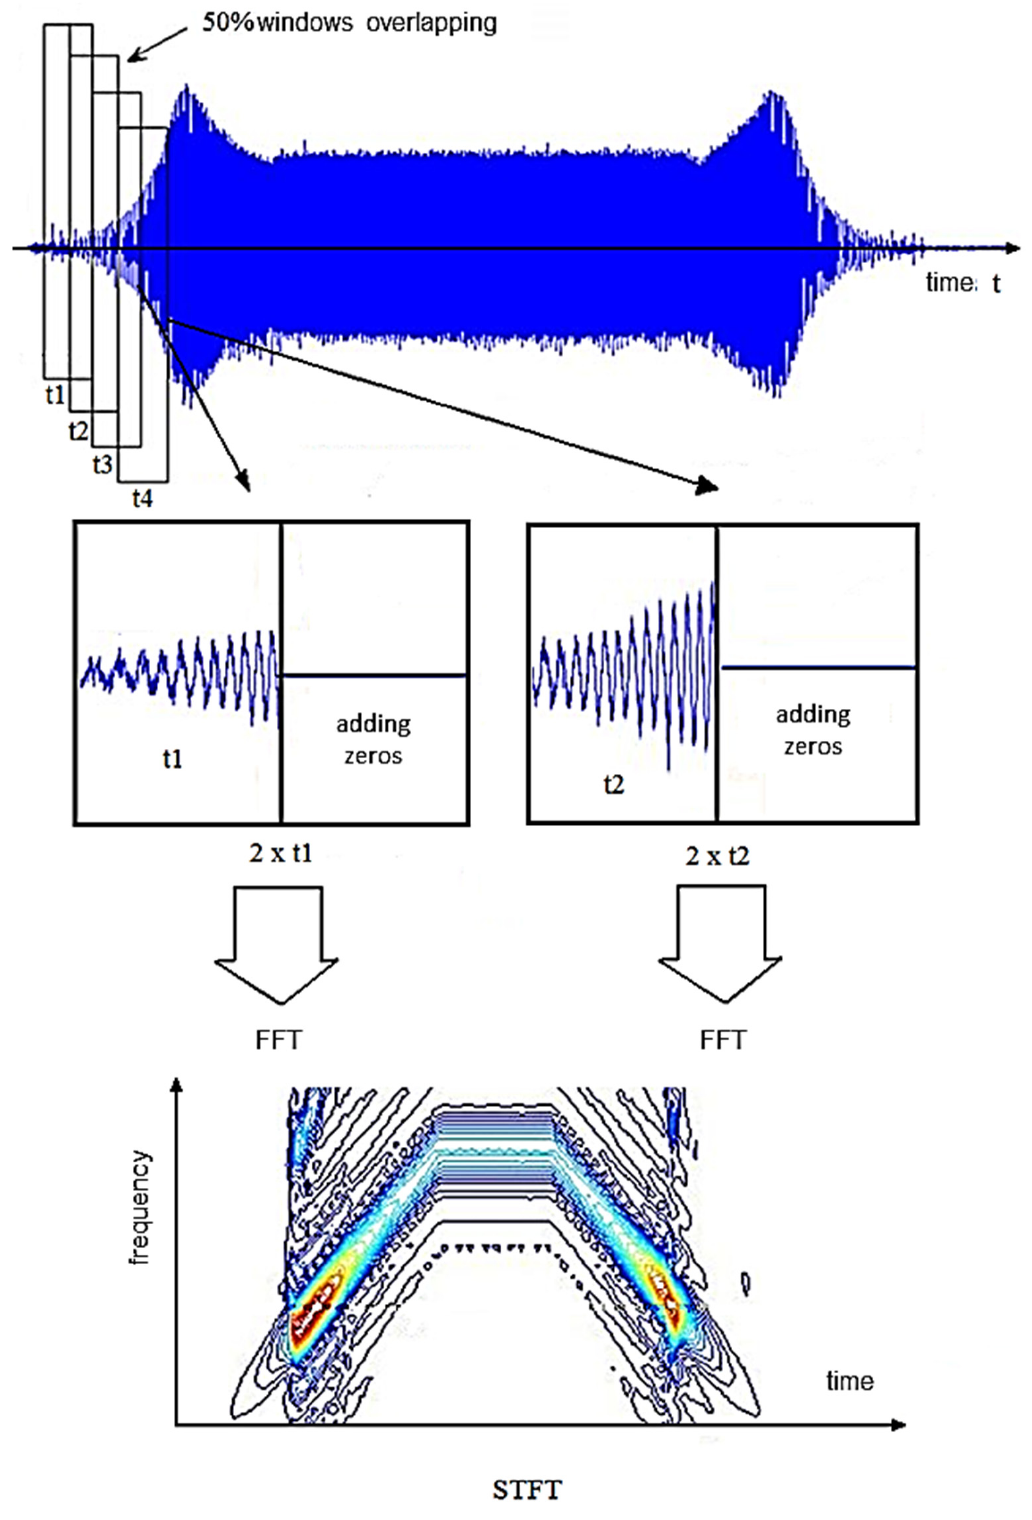
Figure 6. Scheme of signal preprocessing using the STFT with overlapping a window and adding zeros.